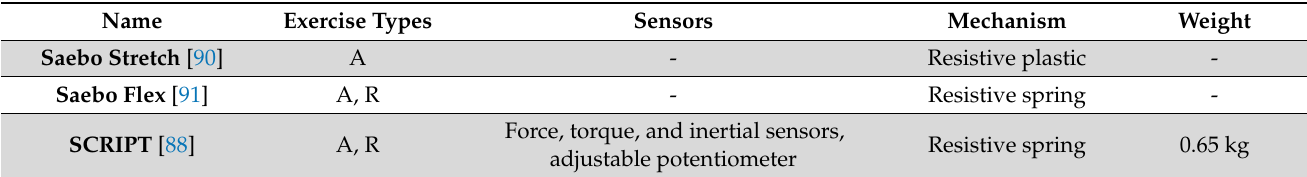
Table 6. Reviewed